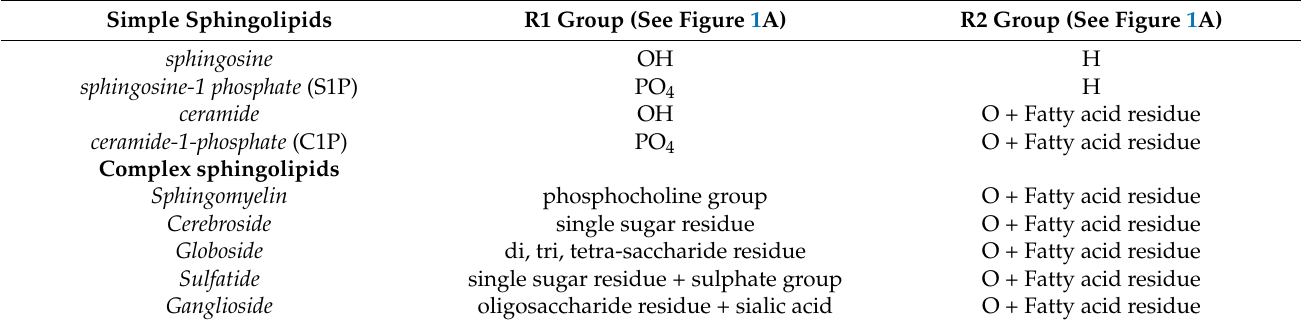
Table 1. Structures of sphingolipids.